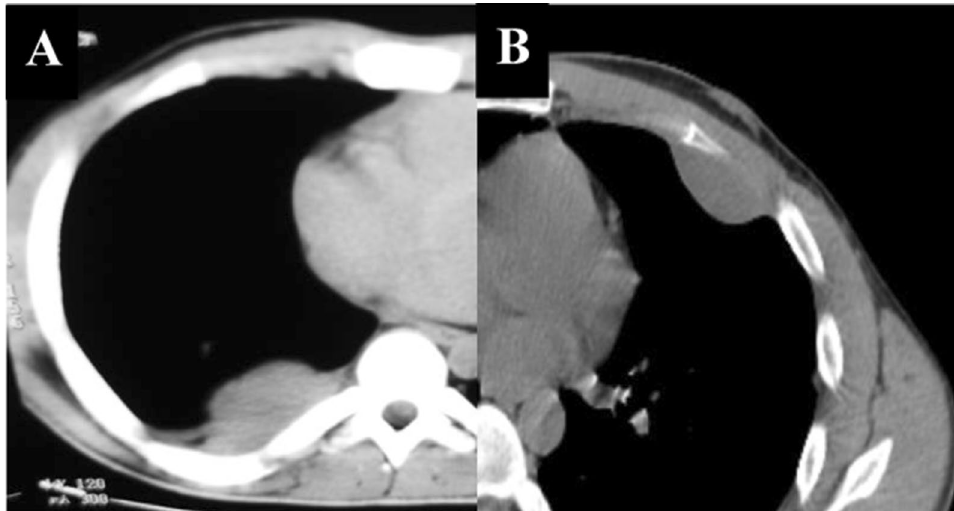
Fig. 8 (A) 22‑year‑old male patient presented with chest pain and dyspnea. Axial CT mediastinal window image showing involvement of the EPS wall swelling and pain. Axial CT mediastinal window image of the lingular segment showing EPS mass (pathologically proved nerve sheath